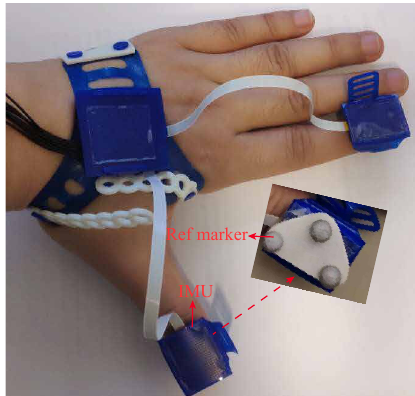
Figure 1. IMUs on the dorsal side of the hand and fingertips. The inset shows the cluster of optical markers used on top of each IMU for reference measurement of segment orientations using the optical VICON system. Every cluster contains three markers, which determine a 3D coordinate